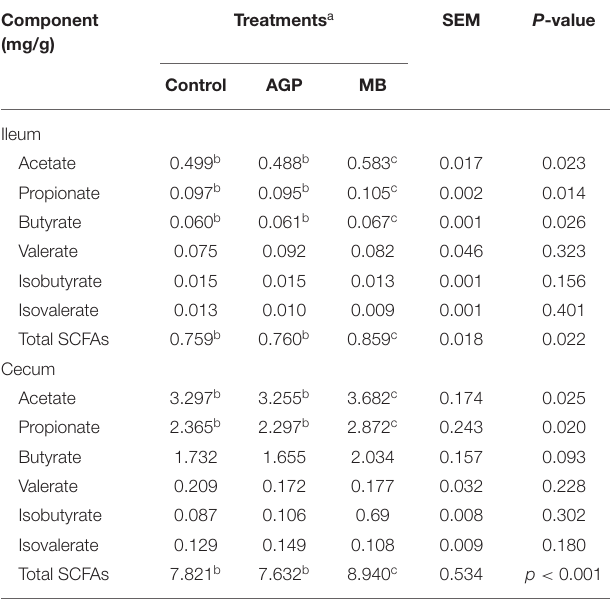
TABLE 6 | Effects of dietary Macleaya cordata extract and Benzoic acid supplementation on short chain fatty acids in intestines of weaned piglets. Component